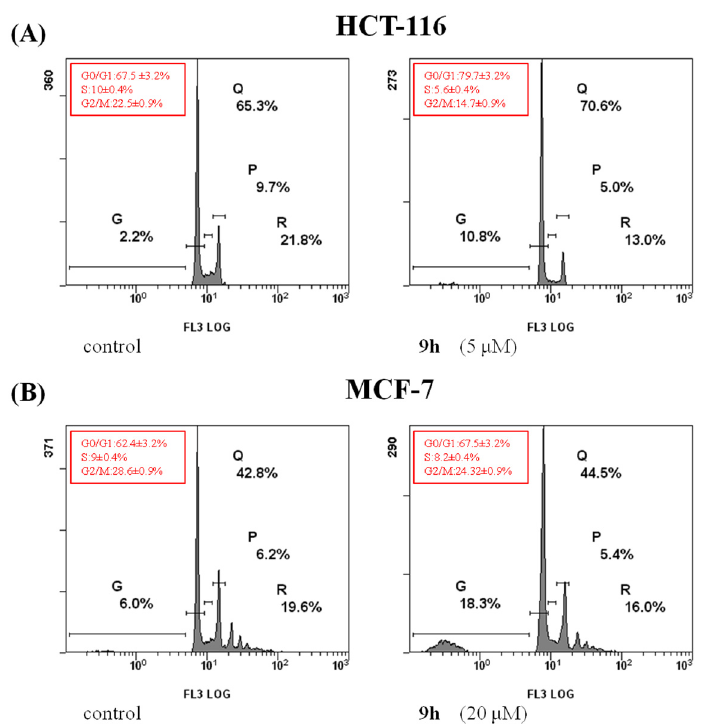
Figure 3. Cell cycle analysis of HCT-116 ( A ) or MCF-7 ( B ) cells treated with compound 9h . Cell monolayers were incubated in the absence (control) or presence of the compound at the GI 50 value. After 24 h incubation, propidium iodide-stained cells were submitted to flow cytometric analysis, as reported in the Experimental Section. The percentage of cells in the different phases of the cycle was calculated by Expo32 software. Images are representative of three experiments with comparable results. Inset: percentage of viable cells ±SD in the different phases.